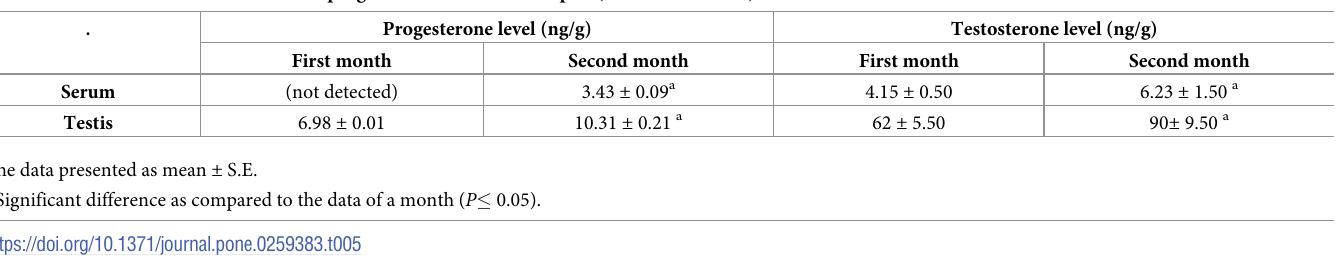
Table 5. Mean values of testosterone and progesterone in control samples (n = 4/each month). .